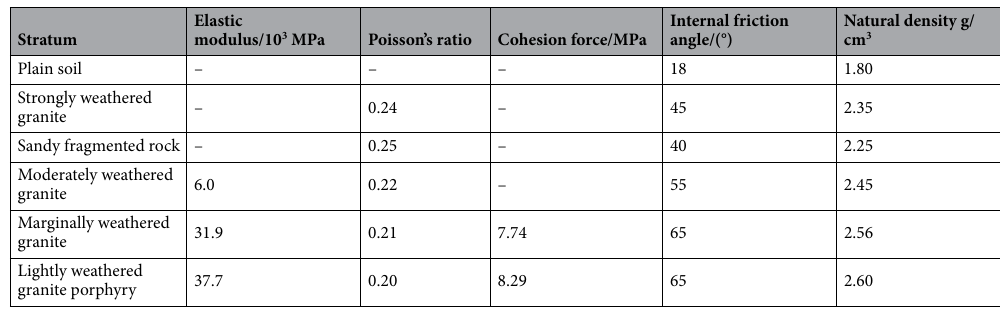
Table 1. Rock parameter table of subway station.